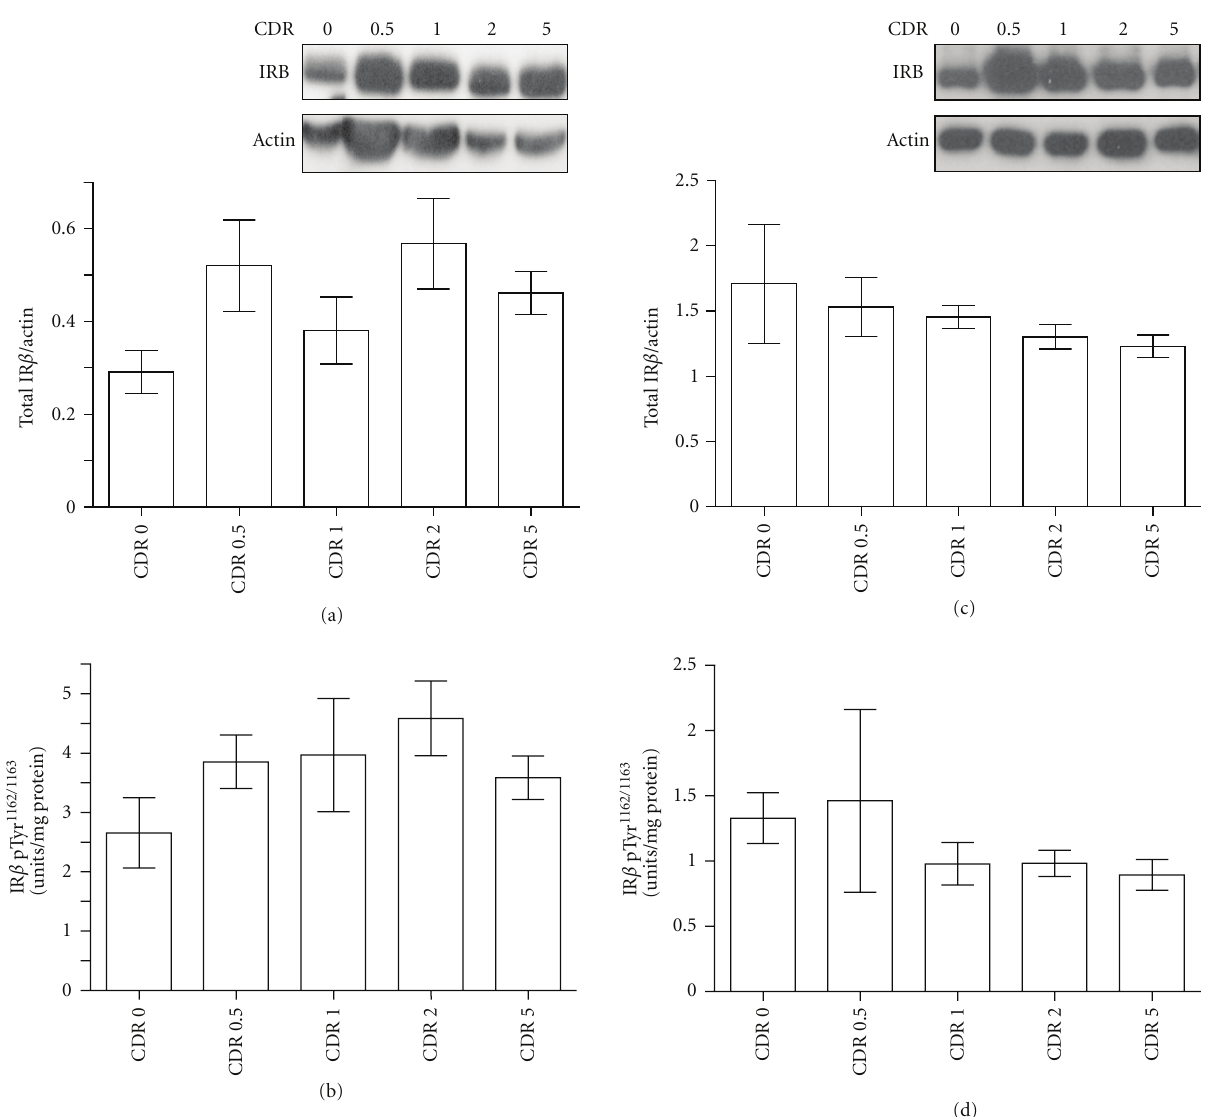
Figure 2: Total IR β and [Tyr1162/1163]-phosphorylated IR β contents in peripheral temporal muscle and in brain hippocampal formation specimens as a function of CDR. Total insulin IR β contents in temporal muscle (a) and in the hippocampal formation (c) were assessed by western blot analysis using a commercial antibody that is selective for IR β and is not cross-reactive with IGF-1R β . Contents of [Tyr1162/1163]-phosphorylated IR β in temporal muscle (b) and in the hippocampal formation (d) were assessed by a commercial ELISA that is specific for [Tyr1162/1163]-phosphorylated IR β , and is not cross-reactive with IGF-IR β . In ((a) and (c)), total IR β contents are expressed relative to β -actin levels assessed on the same Western blot using a specific β -actin antibody (Sigma, MO). Inset: representative western blot analysis of total IR β and β -actin contents in muscle ((a), inset) and hippocampal formation ((c), inset) from CDR 0, 0.5, 1, 2, and 5 cases. In ((b) and (d)), [Tyr1162/1163]-phosphorylated IR β is expressed relative to total protein contents. In ((a)–(d)), values represent group mean ± SEM values. ANOVA; P = . 976 and .478, respectively, for IR β and [Tyr1162/1163]-phosphorylated IR β in temporal muscle; P = . 220 and .425, respectively, for IR β and [Tyr1162/1163]-phosphorylated IR β in the hippocampal